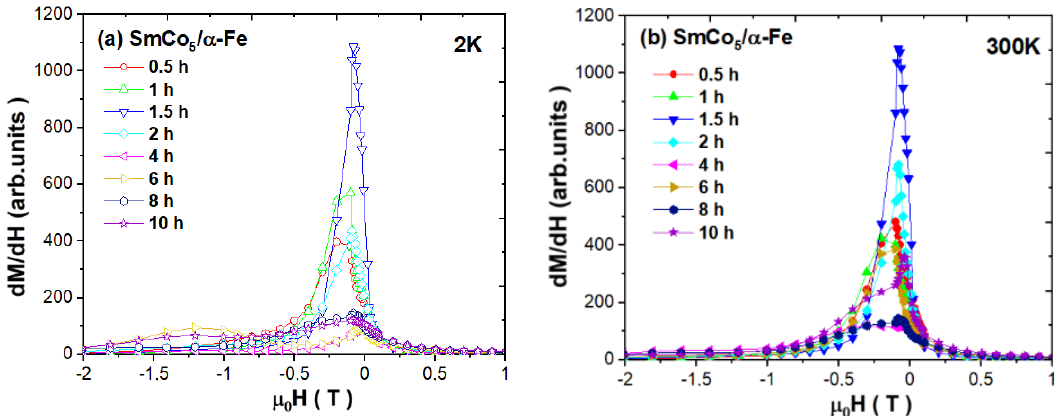
Figure 7. Derivatives of magnetization curves d M /d H versus H measured at ( a ) 2 and ( b ) 300 K for as-milled SmCo 5 /α-Fe (5%wt. of α-Fe) powders.